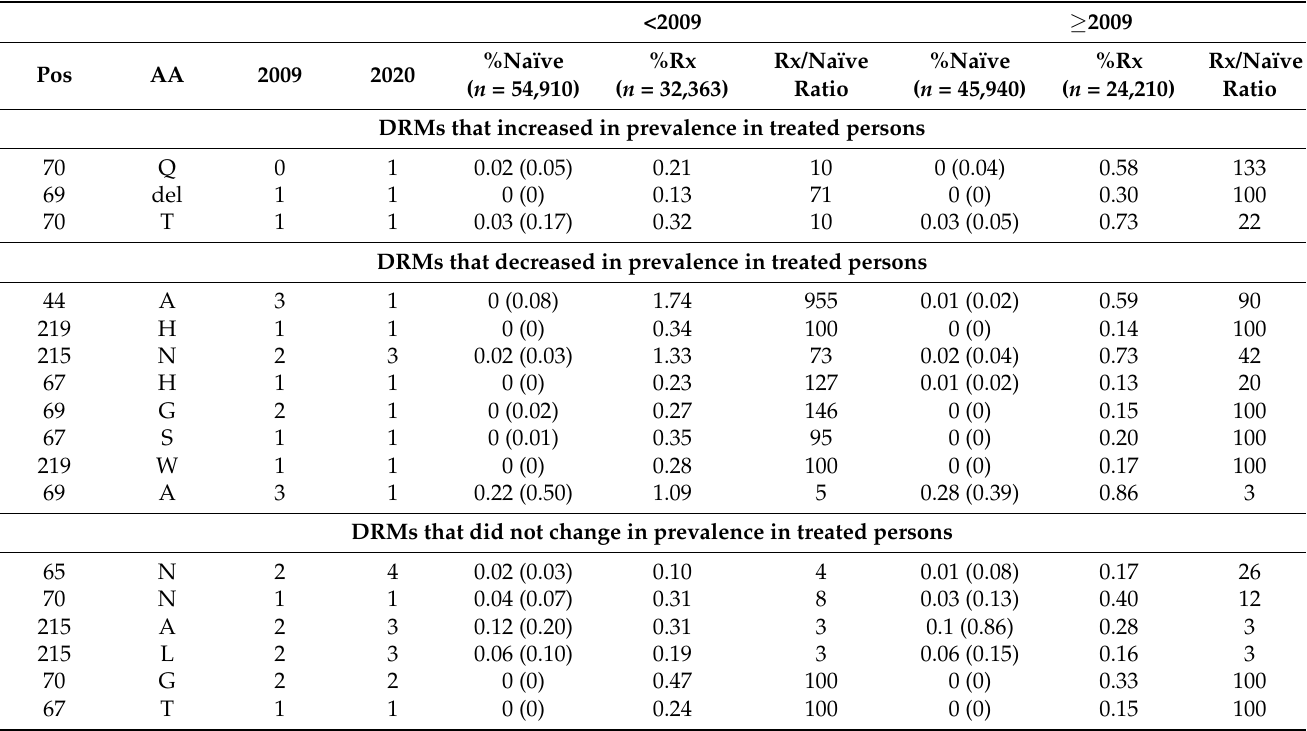
persons. Table S6 contains the ORs and adjusted p values comparing the prevalence of each NRTI-associated SDRM and candidate SDRM before and after 2009 in RTI-naïve and NRTI-experienced persons. Table 2. Prevalence of Additional Nonpolymorphic NRTI-Resistance Mutations in RTI-Naïve and NRTI-Experienced Persons before and after